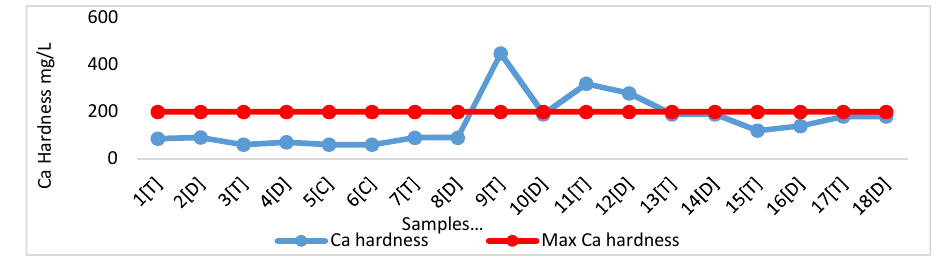
Fig. 6: Calcium Hardness Results of 18 Samples taken from 6 locations in Nawabshah